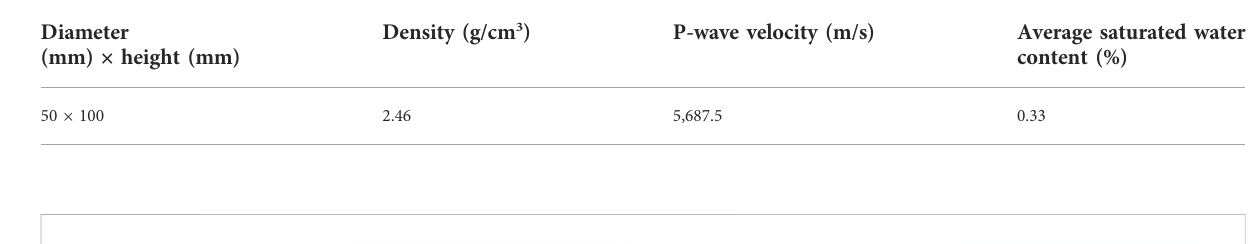
TABLE 2 Basic mechanical parameters of the tested rock.